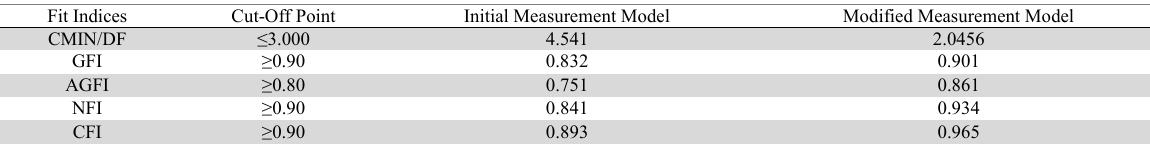
Results of the Measurement Model Fit